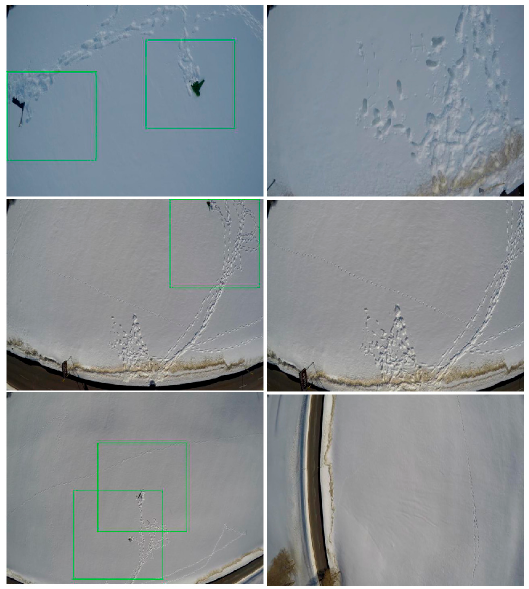
Figure 9. Snapshot of frames with correct positive ( left ) and negative ( right ) detection results at the VGA resolution from the second dataset. Regions of a frame containing an object are shown with a green rectangle. Remote Sens. 2017 , 9 , 100